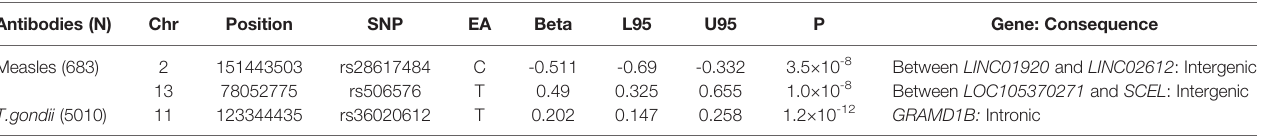
Chr, Chromosome; EA, Effect allele; Beta, Beta estimate for the presence allele; L95, lower 95% con fi dence interval; U95, Upper 95% con fi dence interval; P, p-value.